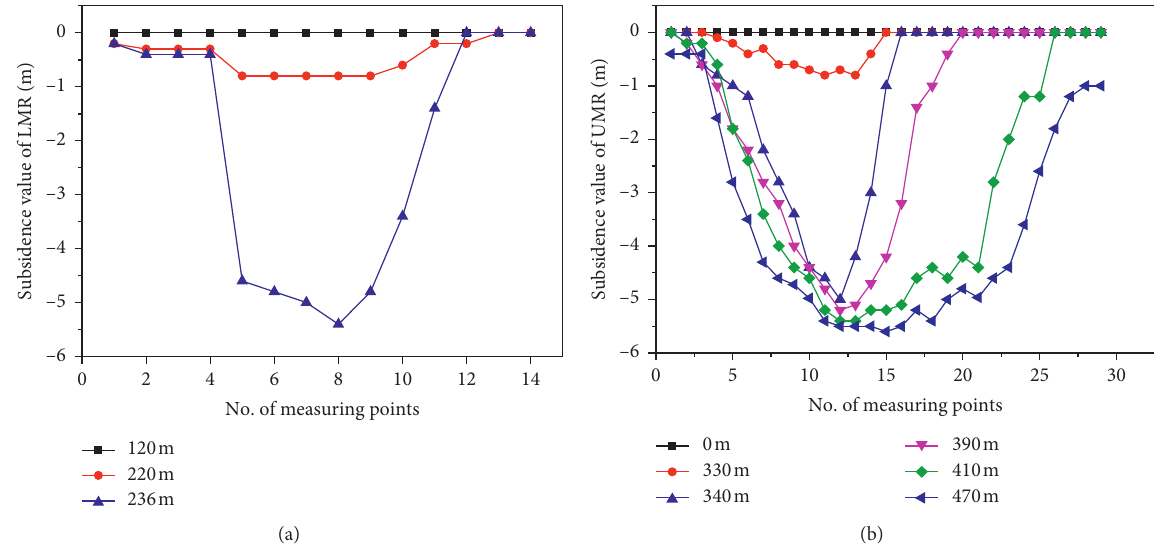
Figure 8: Movement variations of two layers of magmatic rock before and after their breaking. (a) LMR movement before and after its breaking. (b) UMR movement before and after its breaking.